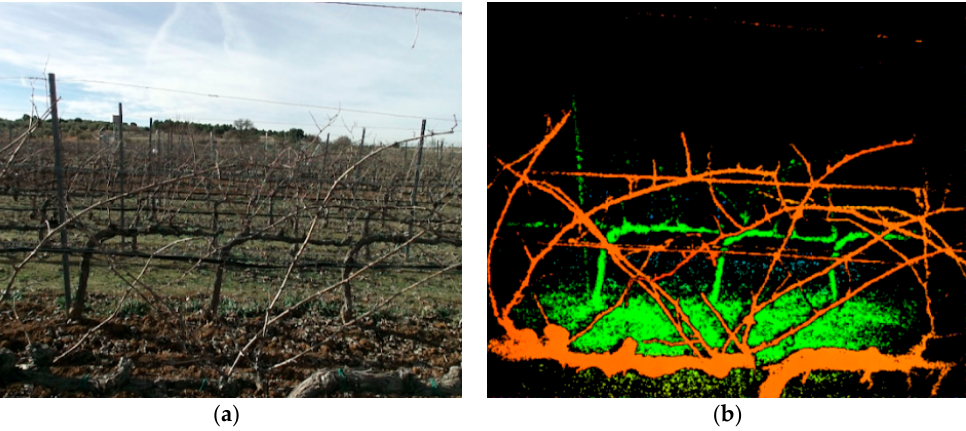
Figure 1. Images supplied by the Kinect v2 sensor. ( a ) Corresponds to the red, green and blue (RGB) channel. ( b ) RGB depth image in a false colour scale where orangeish colours represent the foreground and greenish colours the background vines architecture.